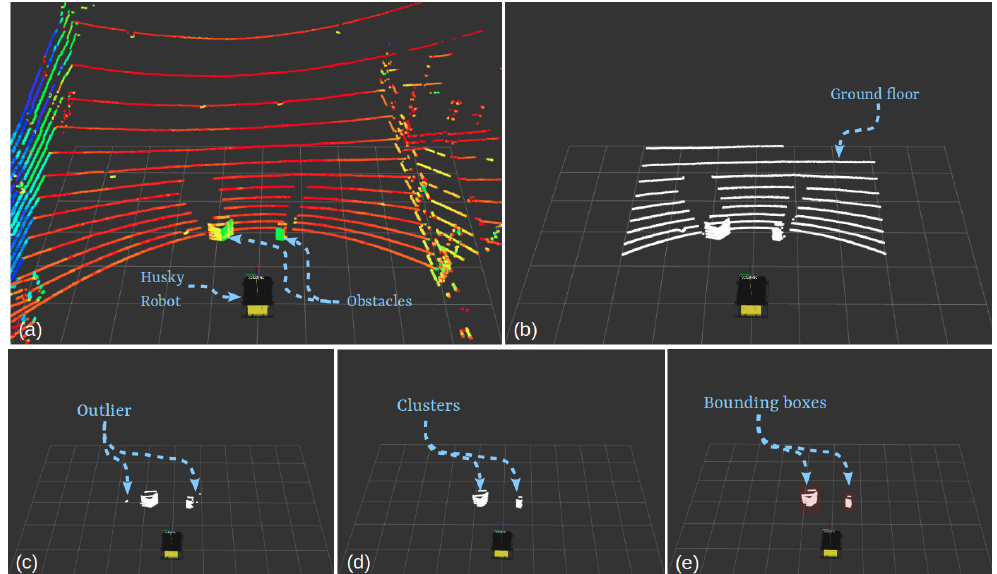
Figure 6. Perception module steps: ( a ) raw PointCloud, ( b ) pass-through, ( c ) plane removal, ( d ) outlier removal and clustering, and ( e ) bounding-box